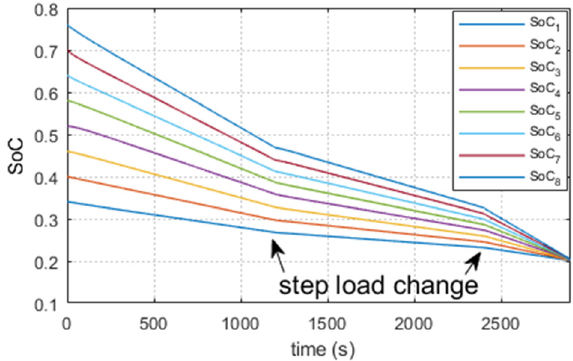
Figure 2. Effects of time-oriented State-of-Charge (SoC) balancing method. Figure 2. E ff ects of time-oriented State-of-Charge (SoC) balancing